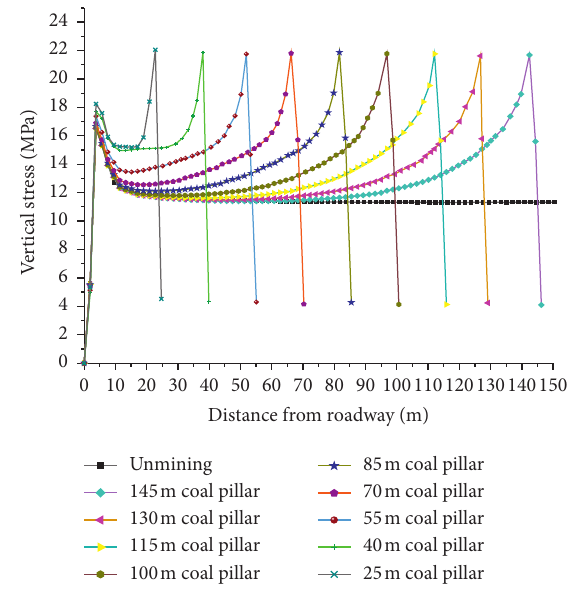
Figure 9: Stress curve with different widths of the coal